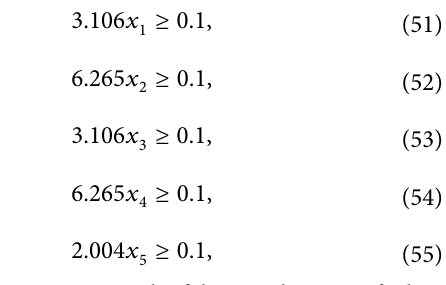
Figure 10: Convergence characteristics of JAYA for 20-time execution for case 3 for the objective function mentioned in equation